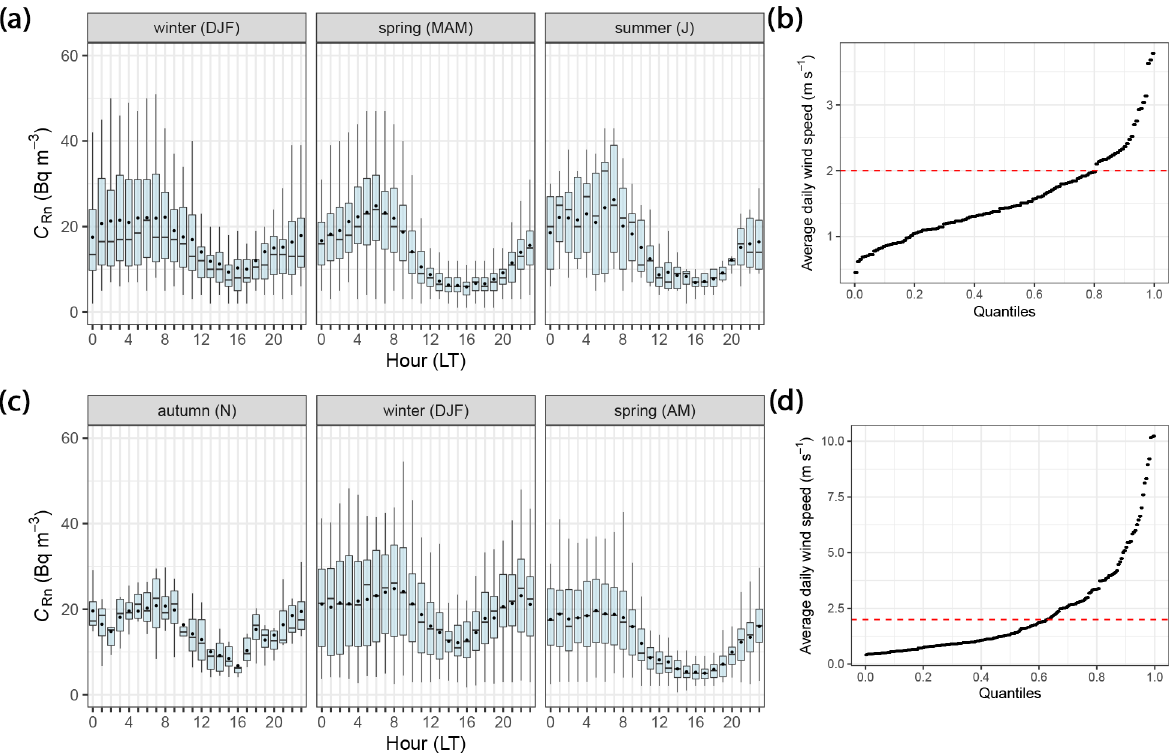
Figure 3. Diurnal variation (local time: CET/CEST) in radon concentration ( C Rn ) in Ljubljana (a) and Vipava valley (c) , grouped by season for the whole period of Rn measurements. Statistics for every hour in a day are represented by a box plot derived from 1h data (point: mean; horizontal line: median; grey-coloured box: 25th–75th percentiles; whiskers: 5th–95th percentiles). Only days during which daily average wind speed is below 2ms − 1 are considered. Distribution of wind speed for Ljubljana and Vipava valley is presented in (b) and (d) .